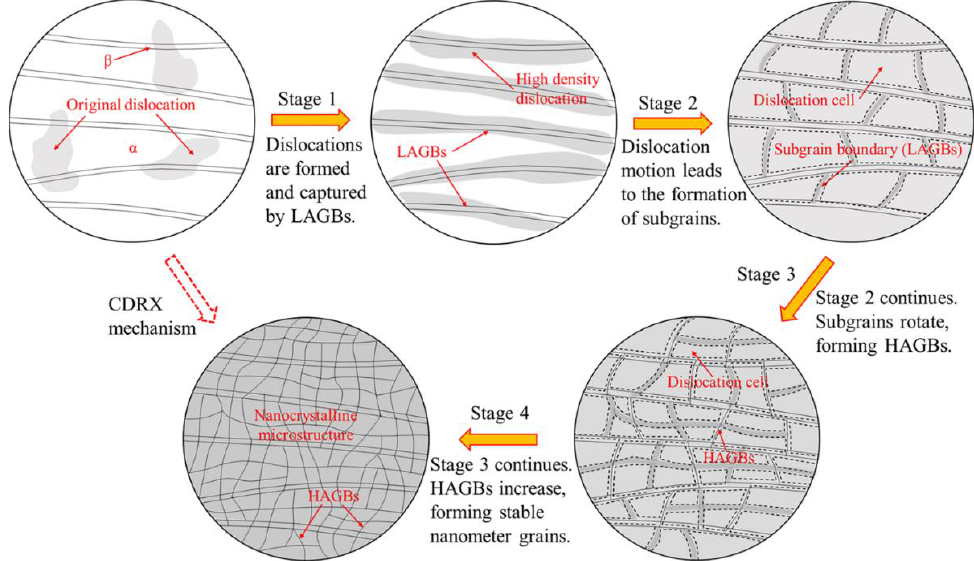
Figure 11. The formation process of surface nanocrystalline microstructure. Reprinted with permission from Ref. [7]. Copyright 2022 Elsevier.